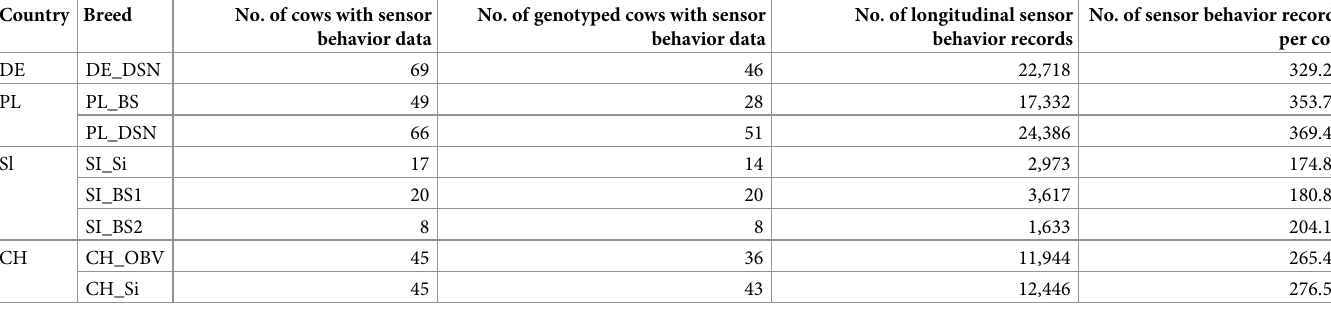
Table 4. Data structure for the cattle breeds included in multi-breed GWAS and genetic parameter estimations. Country Breed No. of cows with sensor No. of genotyped cows with sensor behavior data behavior